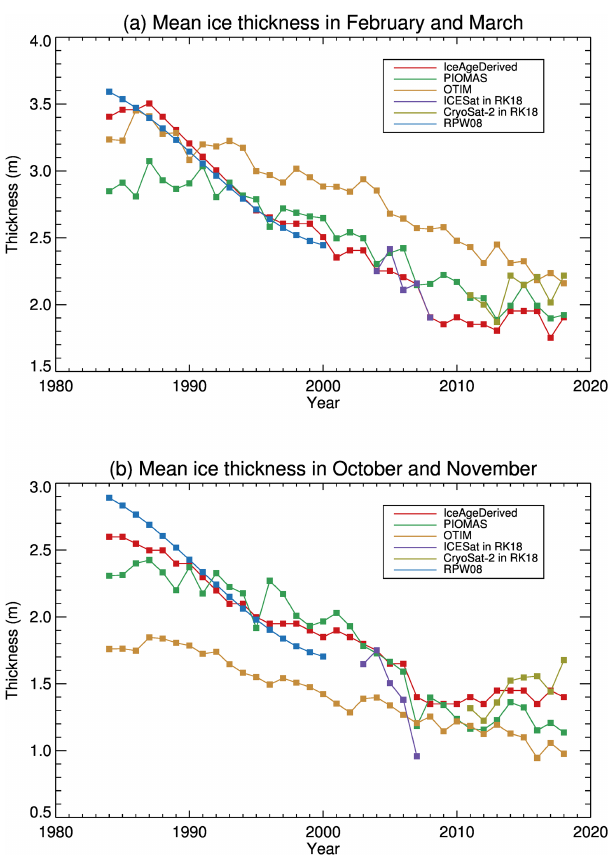
Figure 15. Mean ice thickness in February and March (a) and from October and November (b) from 1984 to 2018 derived from ice age, PIOMAS, OTIM, ICESat (2004–2008), CryoSat-2 (2011–2018), and submarine data (1984–2000) over the SCICEX data release area.